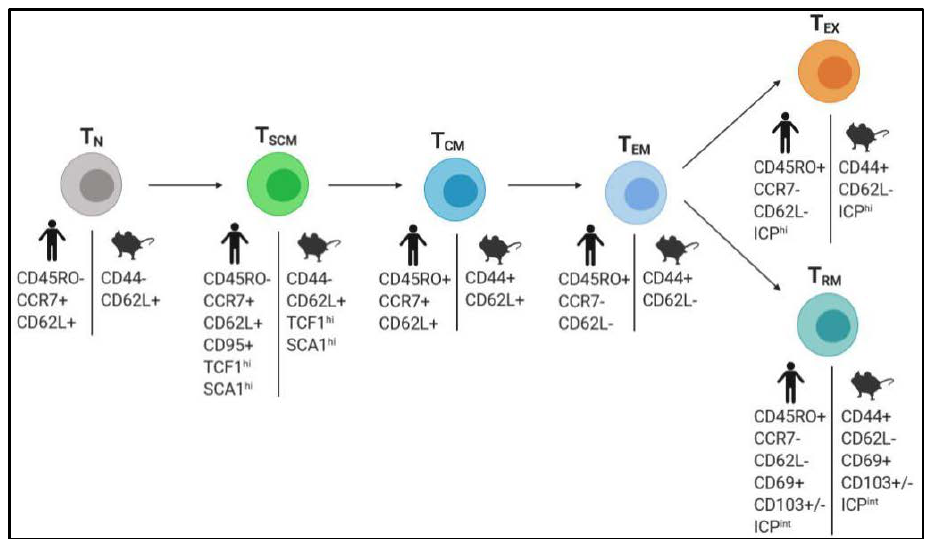
Figure 2. Core phenotypic characterization of memory T cell subsets. T N , naïve T cell; T SCM , stem cell-like memory T cells; T CM : central memory T cell; T EM , effector memory T cell; T RM , resident-memory T cells; T EX , exhausted/dysfunctional T cell; ICP, immune checkpoint.